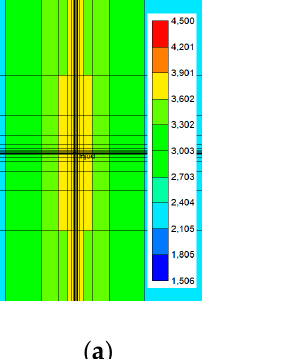
Table 4. Different scenarios used in the study of soaking period effect.